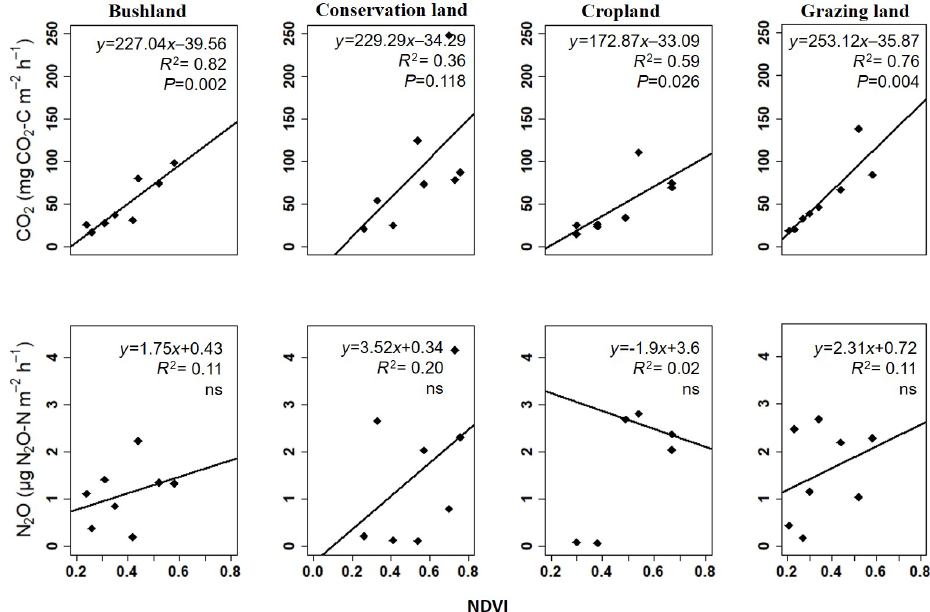
Figure 7. Linear regression analyses of the measured seasonal means for soil CO 2 and soil N 2 O emissions during the campaign from November 2017 to November 2018 plotted against NDVI data acquired during each campaign; ns = not